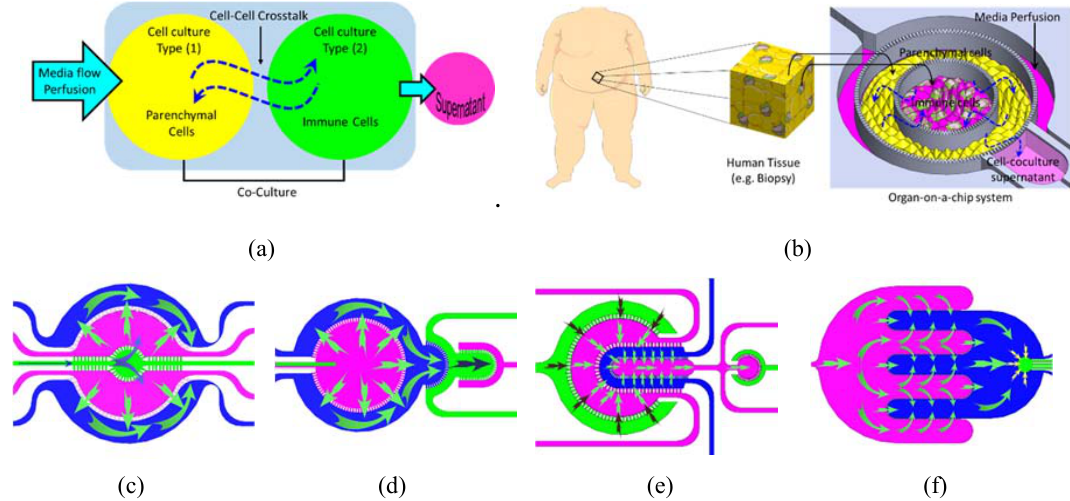
Figure 1. ( a ) Conceptual schematic drawing of the perfusion compartmentalized system with the proposed cell culture. ( b ) A biological model (co ‐ culture) hosted within the perfusion system. ( c – f ) Fabricated and tested microfluidic chip showing suggested inter ‐ compartment fluidic crosstalk.